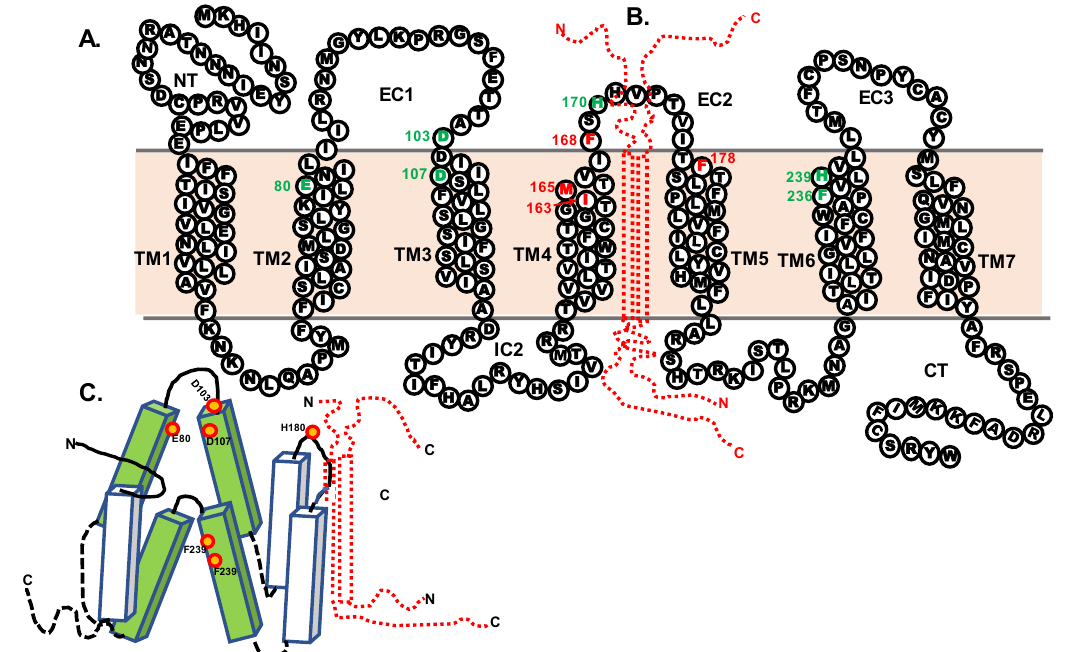
Figure 5. ( A ) This figure is a two-dimensional view of hMC2R based on the amino acid sequence presented in Figure 1. Amino acid positions highlighted in green are important for activation [4,6]. Amino acid positions highlighted in red play a role in trafficking (Figure 4). ( B ) A cartoon of mMRAP1 (red; not drawn to scale) is superimposed between TM4 and TM5. It is intended to show the orientation of mMRAP1 relative to hMC2R in the hMC2R/mMRAP1 heterodimer. ( C ) This cartoon depicts the predicted conformation of hMC2R with a “closed” HFRW binding site prior to an ACTH binding event. A diagram of mMRAP1 ( red ) is superimposed at the TM4/EC2/TM5 domain. The relative position of critical amino acid positions predicted to be involved in activation are highlighted in orange [19,20].